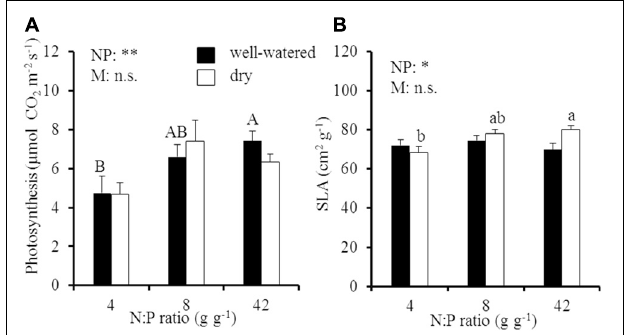
FIGURE 2 | (A) Area-based instantaneous late-summer photosynthesis (A 800 ) and (B) specific leaf area (SLA) of young Palestine oak ( Quercus calliprinos ) trees grown at increasing soil N:P ratio and decreasing soil moisture in a climate chamber. Shown are means and standard errors for replicate saplings ( n = 24). The results of two-way ANOVAs on the significance of the effect of soil N:P ratio (NP) or soil moisture (M) are indicated by asterisks ( ∗ and ∗∗ for p ≤ 0.01 and 0.05; n.s., not significant). Significant differences at p ≤ 0.05 between soil N:P ratios are indicated for well-watered soil by different upper-case letters and for dry soil by different lower-case letters.